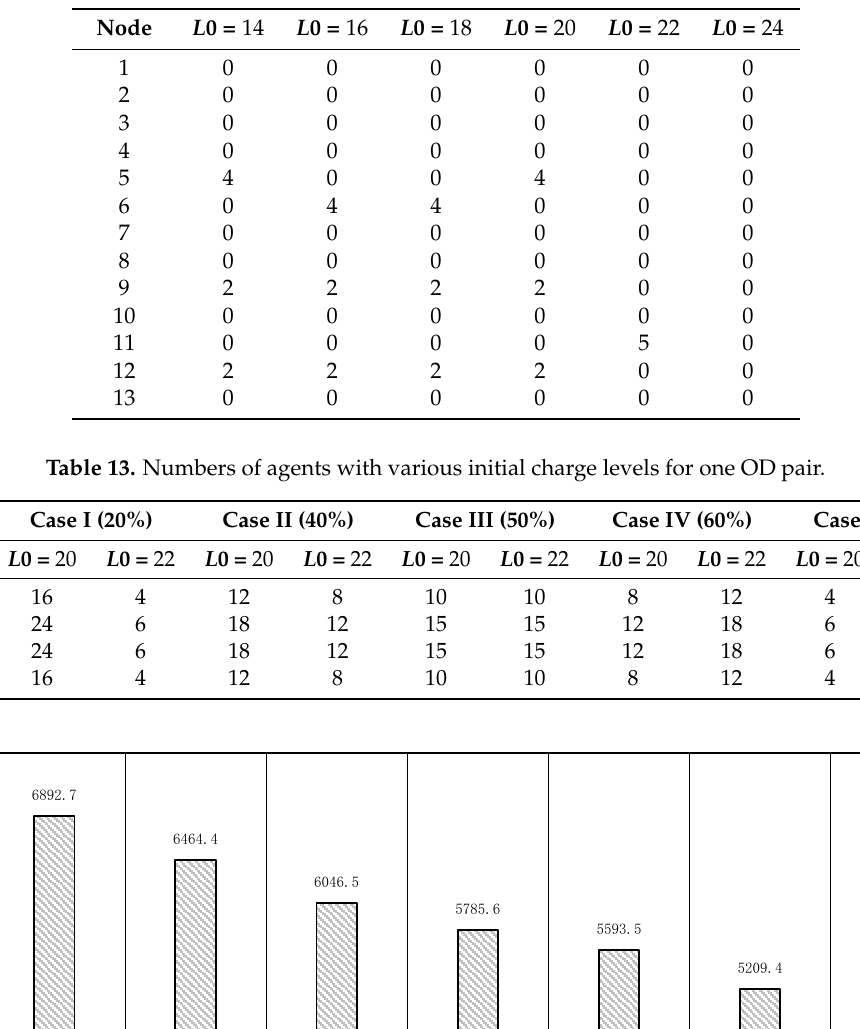
Table 12. Number of chargers at every node for various initial battery charge levels.